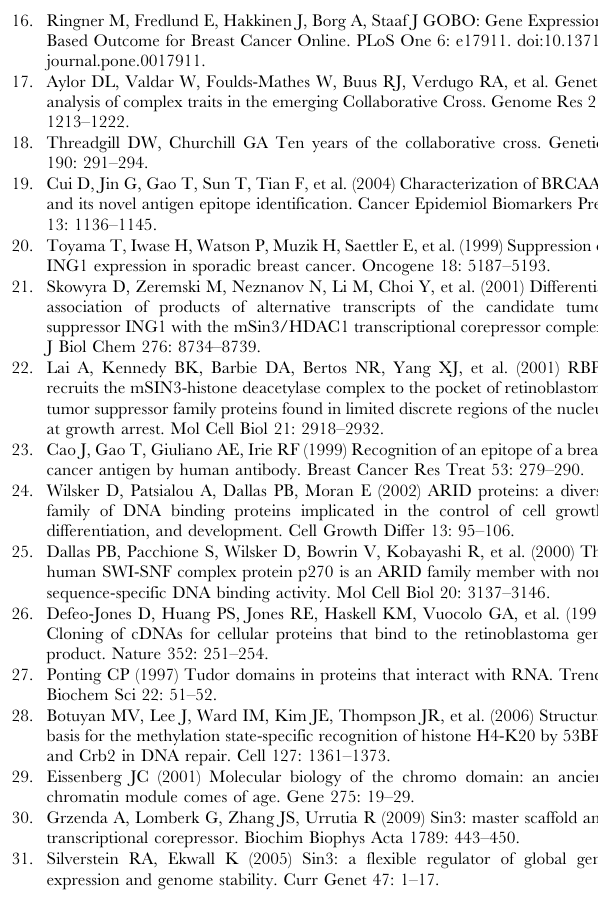
Figure S1 Interval mapping for metastatic progression in the AKXD recombinant inbred panel. A potential QTL peak was detected on proximal chromosome 13. Likelihood ratio score (LRS) for correlation with metastasis is shown in blue with the AKR genotype in red and the DBA genotype in green. Figure S2 Quantitation of Arid4b expression in stable cell lines. QRT-PCR data (A) was internally normalized to Ppib and fold change expressed relative to Met-1 cells stably expressing lacZ . Western blots confirm upregulation of the AKR and DBA alleles at the protein level relative to endogenous expression in lacZ controls (B).